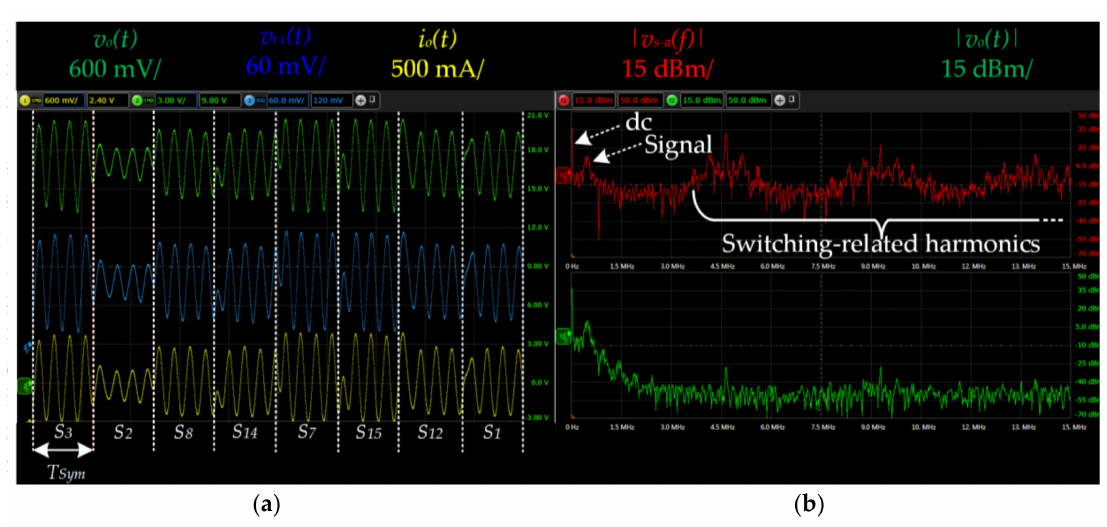
Figure 16. ( a ) Main waveforms of the transmitter where v o ( t ) is the voltage across the LEDs, i o ( t ) is the current through the LEDs and v rx ( t ) is the output voltage of the receiver. The link distance is 15 cm in order to show clear waveforms where the symbols can be easily identified; ( b ) Spectrum of v s − a ( t ) and v o ( t ).